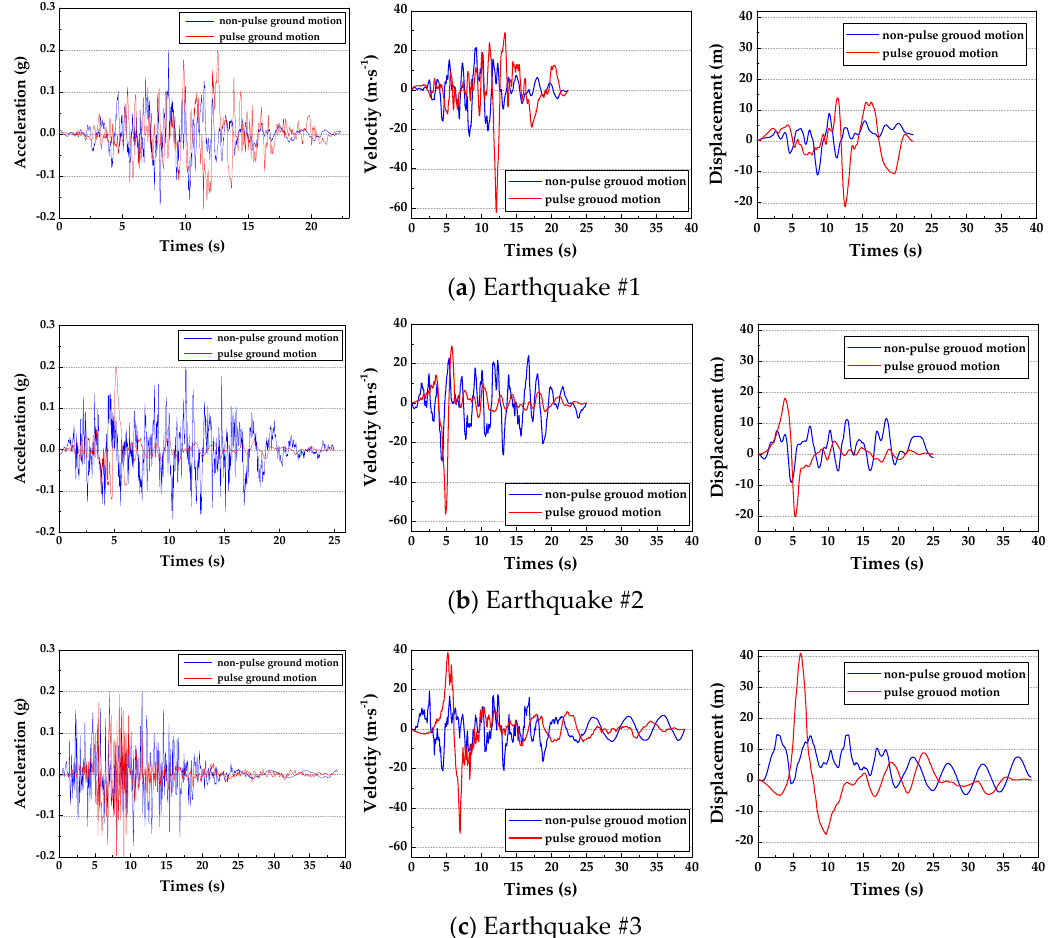
Figure 1. The time-history curves of acceleration, velocity, and displacement of seismic records.